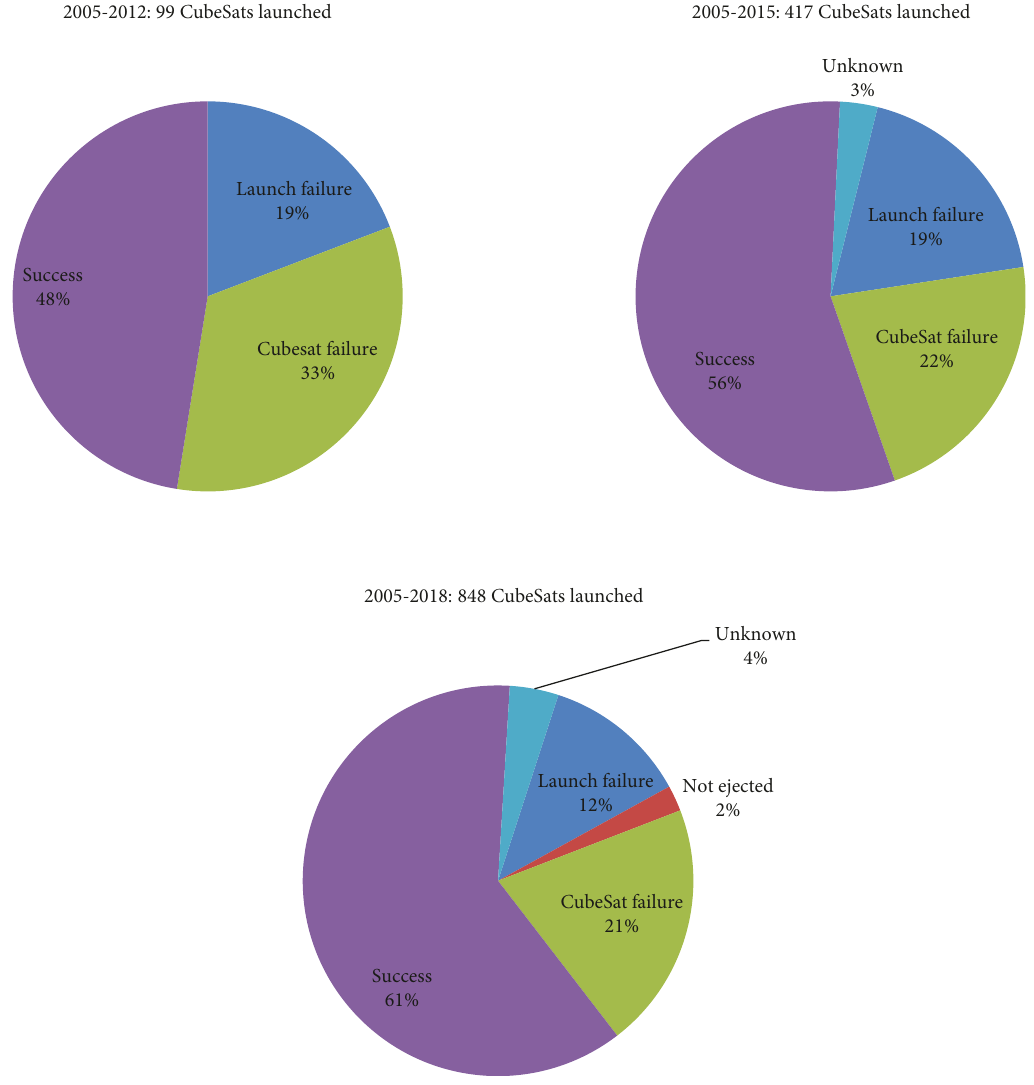
Figure 8: CubeSats mission status according to some time periods as of May 31,